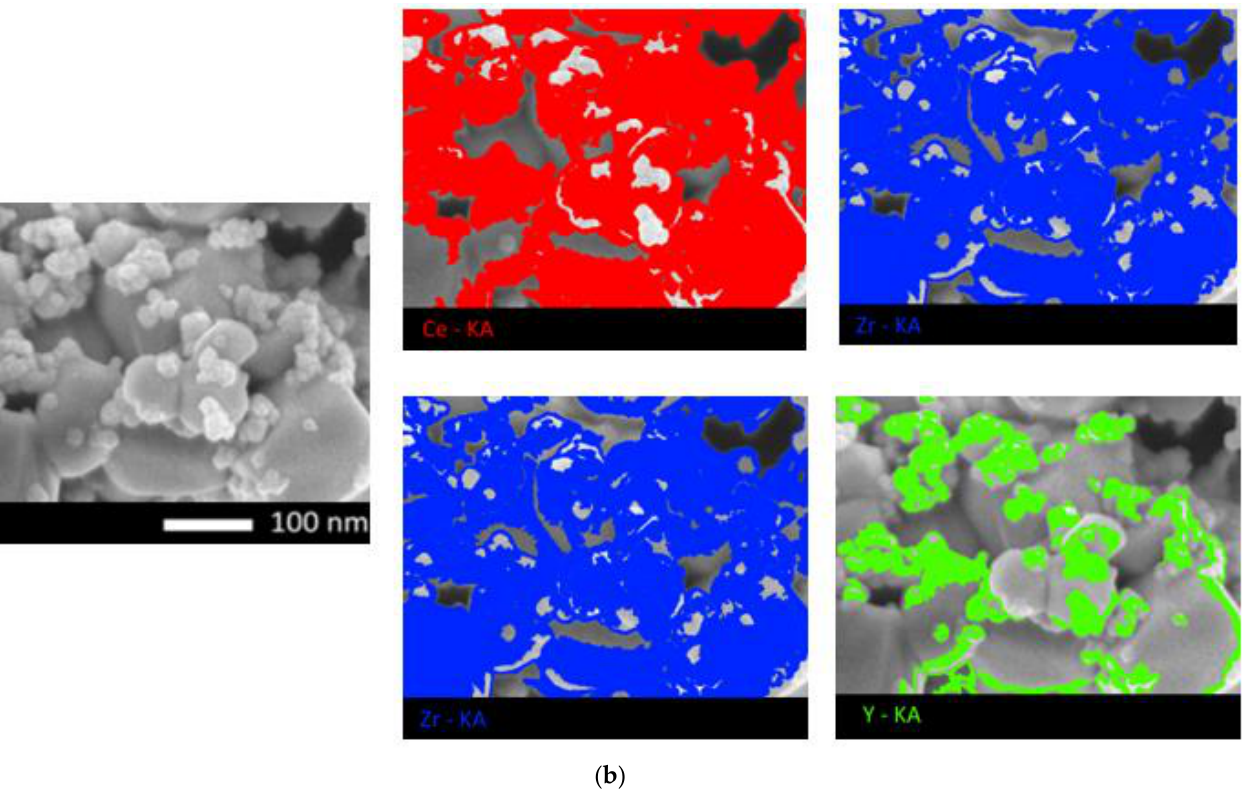
Figure 3 . ( a ) Results of X-ray diffraction of the studied ceramics depending on the concentration of the Y 2 O 3 dopant. ( b ) The results of mapping a ceramic sample with a dopant concentration of 5%.